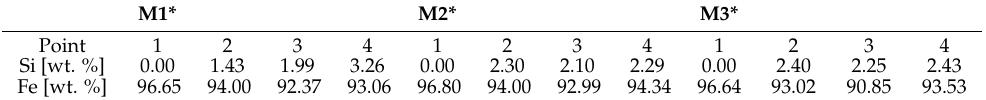
Figure 6. EDS analyzation of microstructure (1: unmolten particle, 2: light area, 3: white needle-like area, 4: dark area). Table 4. EDS measurement corresponding to the microstructures shown in Figure 6.